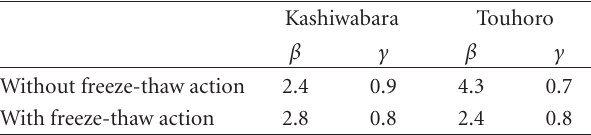
Table 2: Coe ffi cients of β and γ